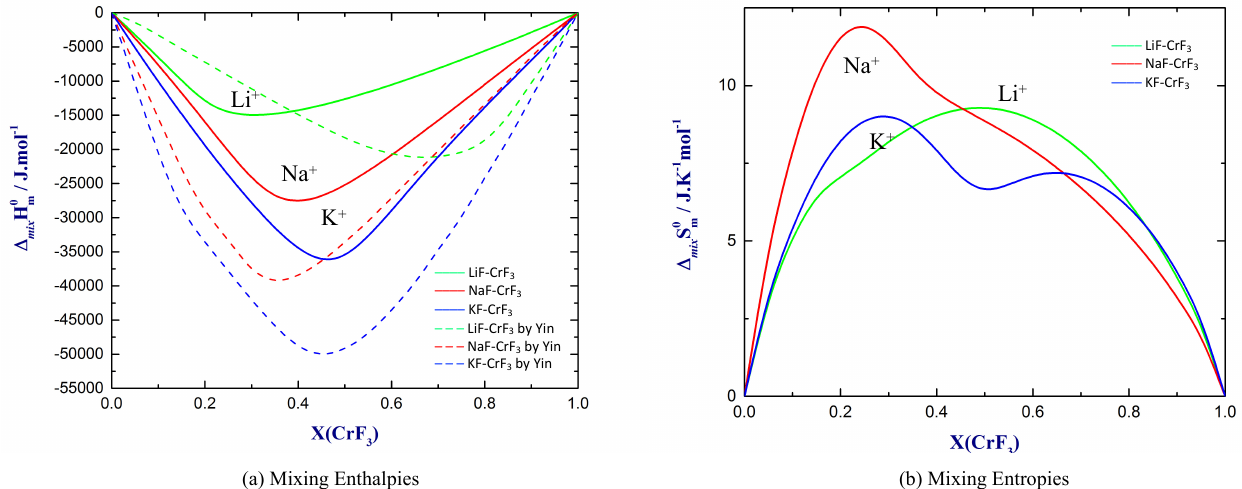
Figure 5. ( a ) Mixing enthalpies and ( b ) mixing entropies of the LiF–CrF 3 , NaF–CrF 3 and KF–CrF 3 systems calculated from the present models at T = 1500 K. Mixing enthalpies represented with dashed lines ( a ) are the values presented by Yin at T = 1500 K